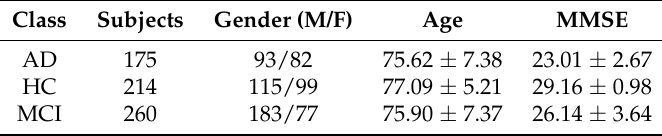
Table 1. Demographic information for 649